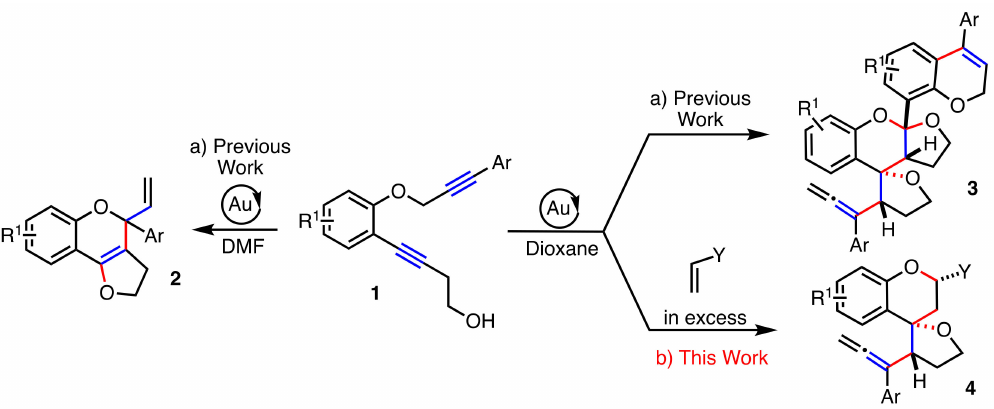
Scheme 1. Gold(I)-catalyzed cascade reaction with 1